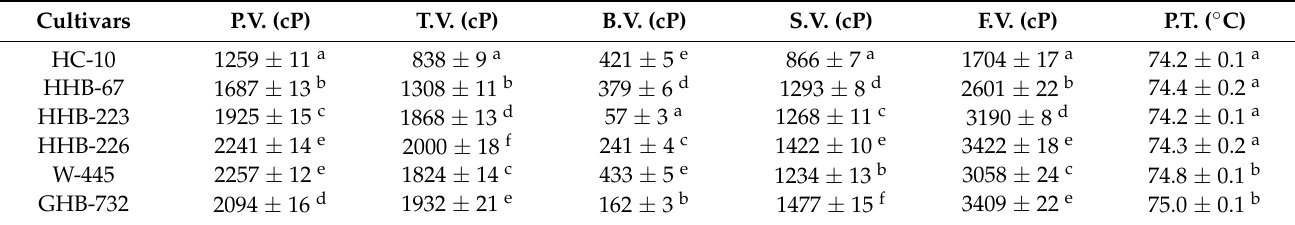
Table 2. Pasting properties of OSA-modified